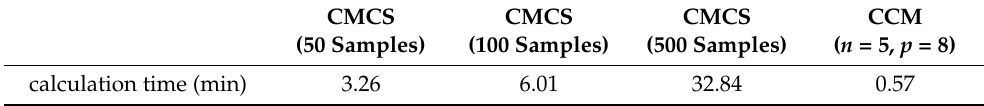
Table 4. Calculation time of transient response of disk 2 with different methods.